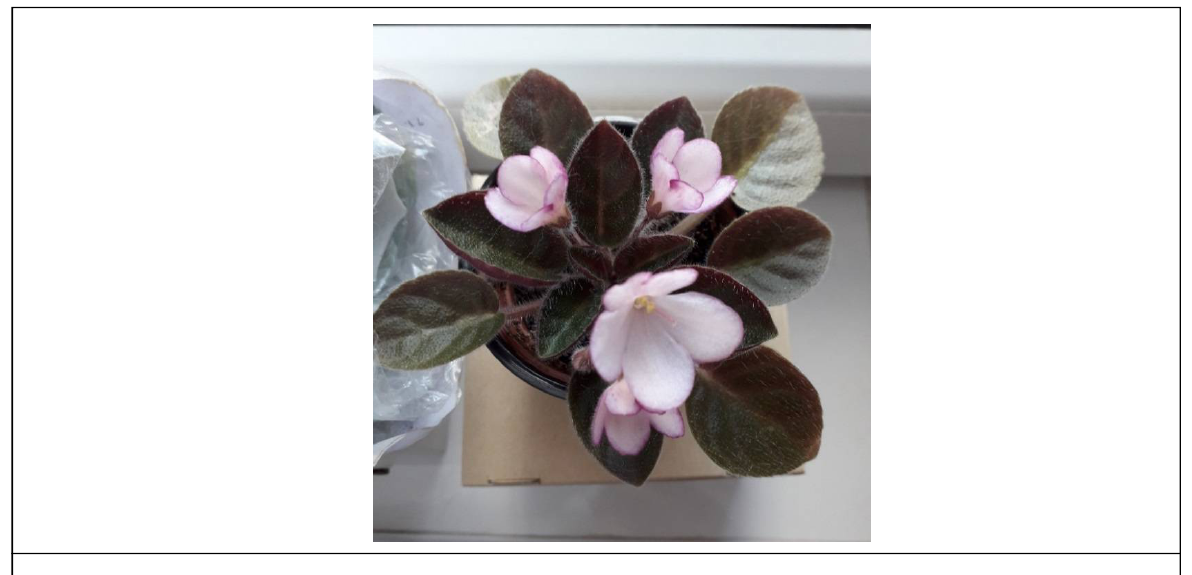
Figure 2: During the experiment (May 22, 2019)